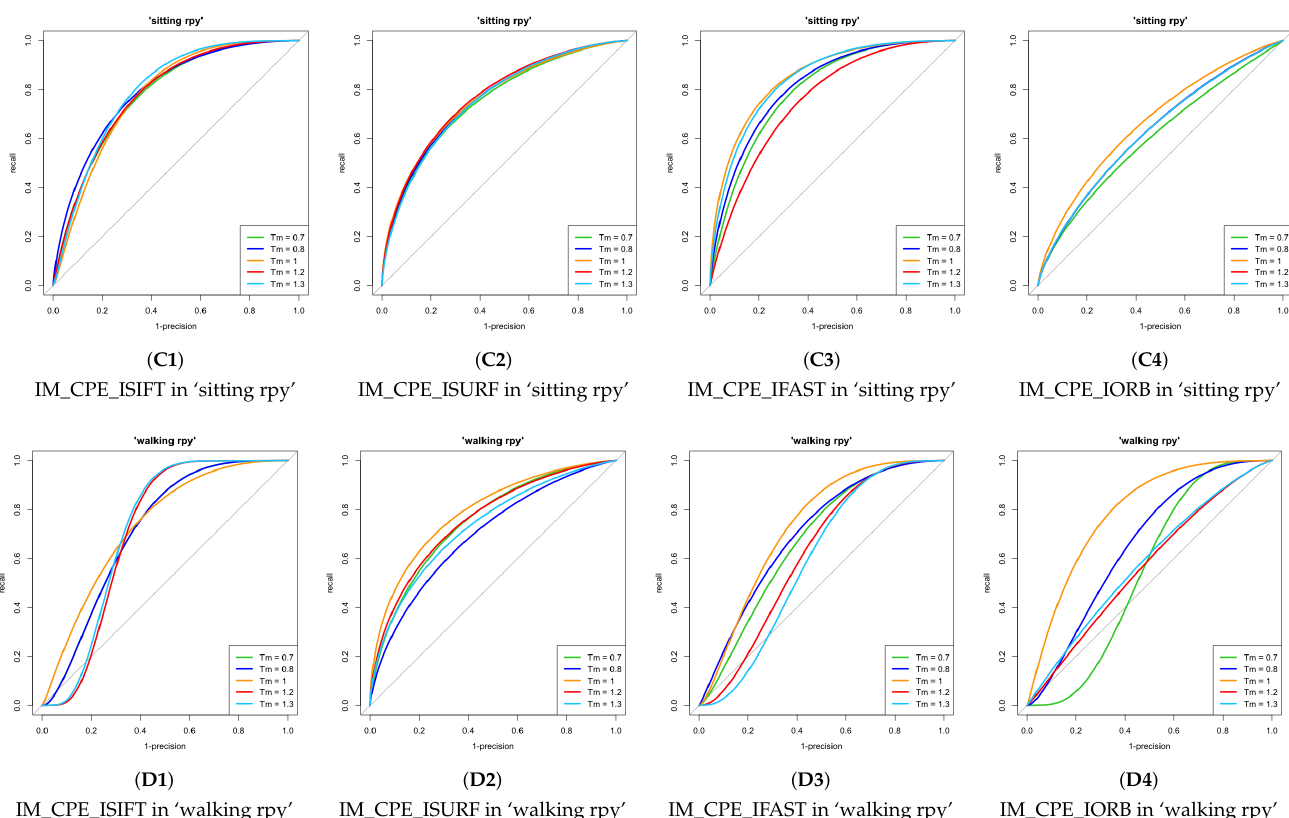
Figure 4. Comparison of proposed IM_CPE in terms of various T M s: 1st row, ‘pioneer SLAM’ sequence; 2nd row, ‘desk’ sequence; 3rd row, ‘sitting rpy’ sequence; 4th row, ‘walking rpy’ se-